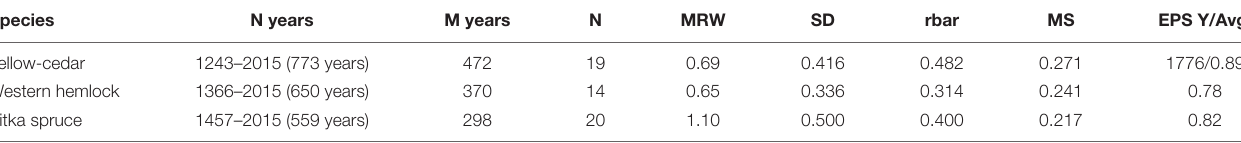
TABLE 1 | Descriptive statistics of full-length species residual chronologies.